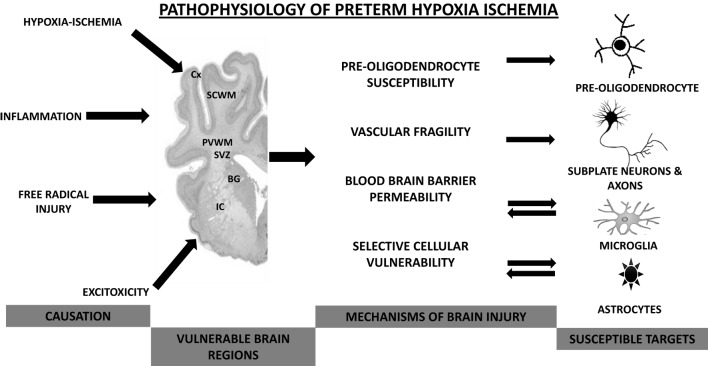
Pathophysiological mechanisms involved in preterm hypoxic–ischemic encephalopathy. Cx, cortex; SCWM, subcortical white matter; PVWM, periventricular white matter; BG, basal ganglia; IC, internal capsule.